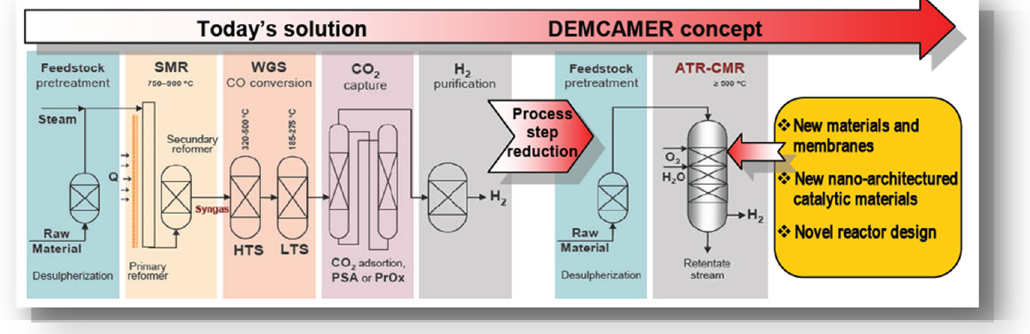
Figure 1. DEMCAMER project concept summarized for the Autothermal Reforming (ATR) process.